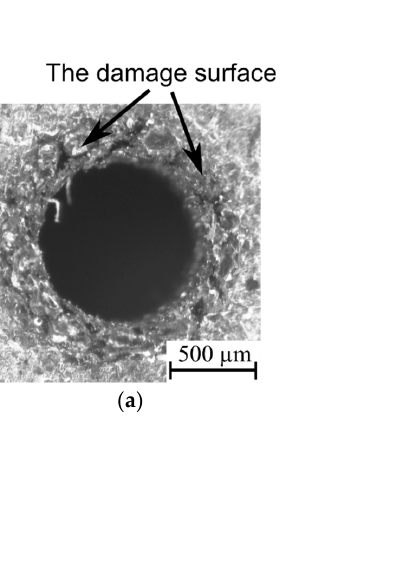
Figure 17. ( a ) The entrance diameter of a micro-hole fabricated with the application of the lower tool electrode rotation n = 100 rpm and U = 100 V, t on = 550 µs, I = 3.33 A, p = 7 MPa; ( b ) the recorded voltage electrode rotation n = 100 rpm and U = 100 V, t on = 550 µ s, I = 3.33 A, p = 7 MPa; ( b ) the recorded and current waveforms for this test. voltage and current waveforms for this